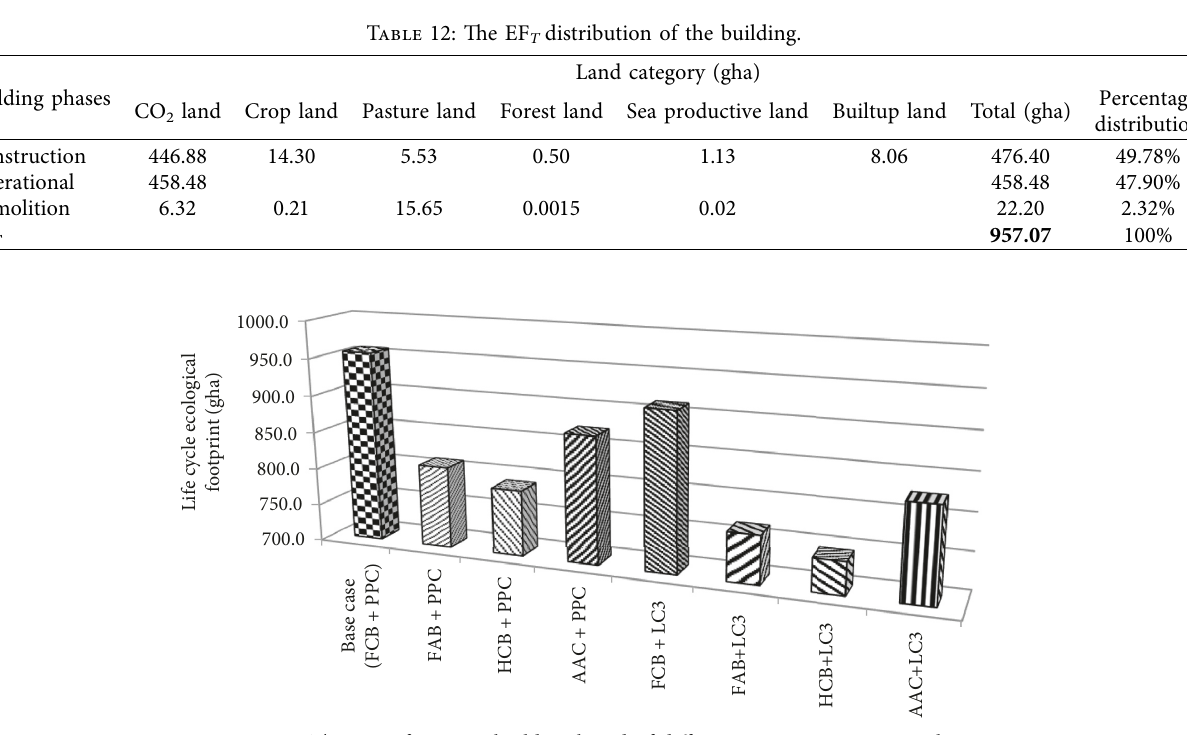
Table 11: Breakup of different bioproductive lands in the EF